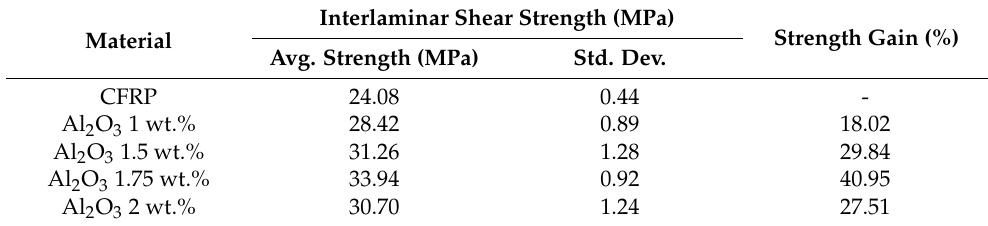
Table 9. Interlaminar shear strength of neat and hybrid SiC nanocomposites.